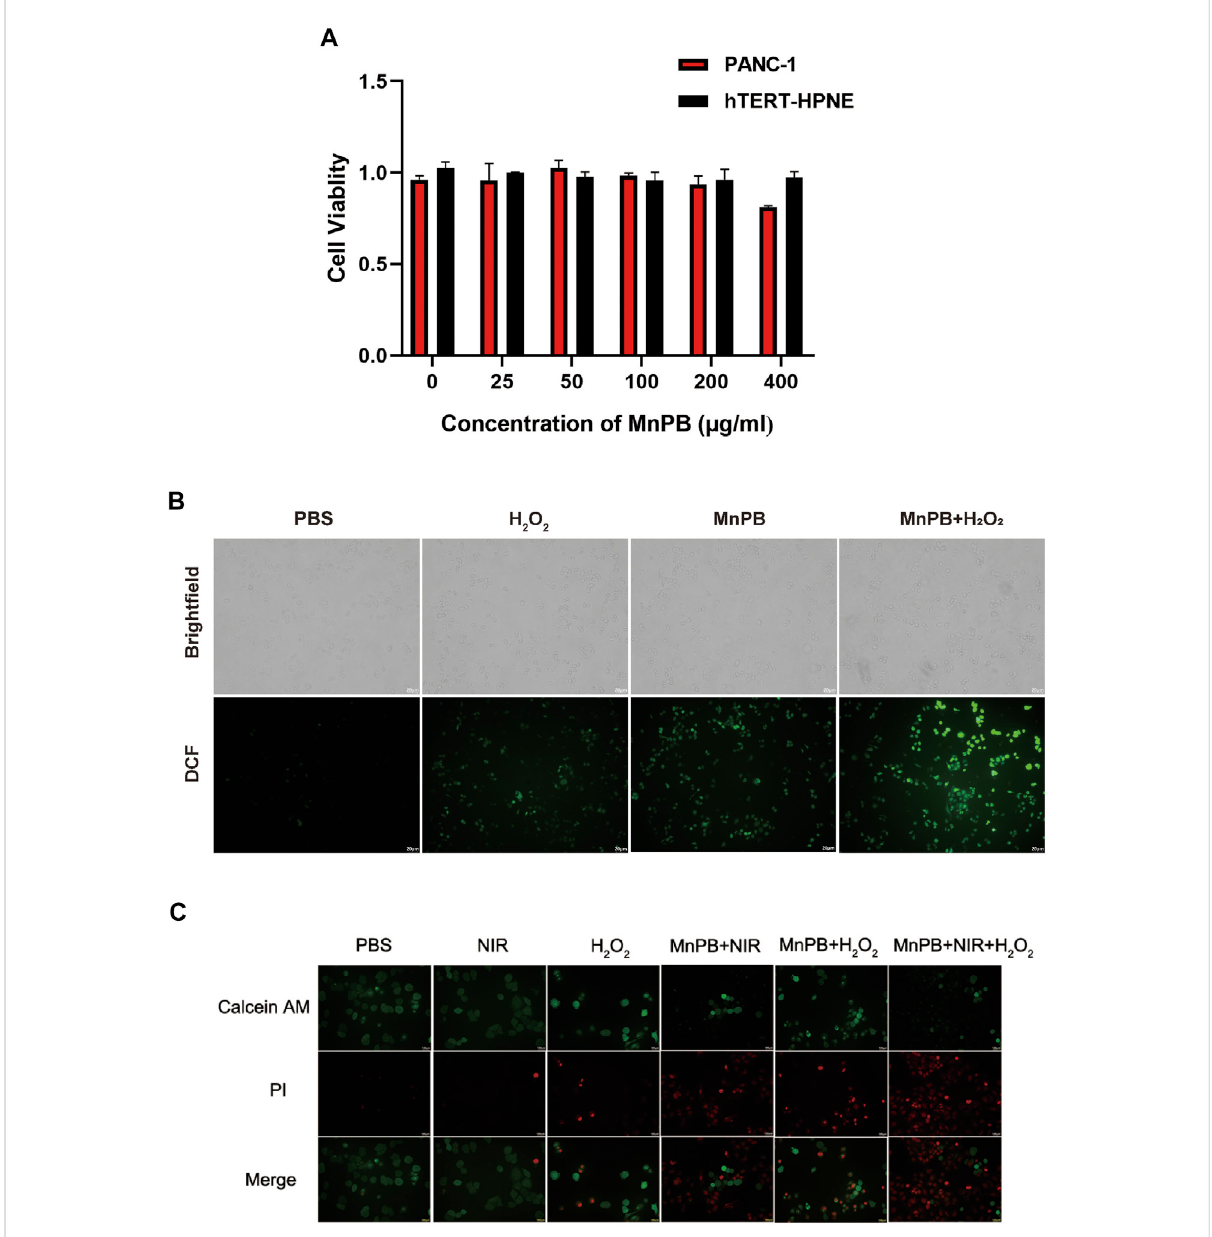
Cell viability and cell death in PC cells with different treatments in vitro (A) viabilityof PANC-1cells and hTERT-HPNEcells with thetreatmentof MnPBNPsfor24 h. (B) Thebright fi eldimagesanddark fi eldimagesofROSlevelinPANC-1cells. (C) ImagesofCalcein-AMandPIco-stainedPANC-1 cells in six